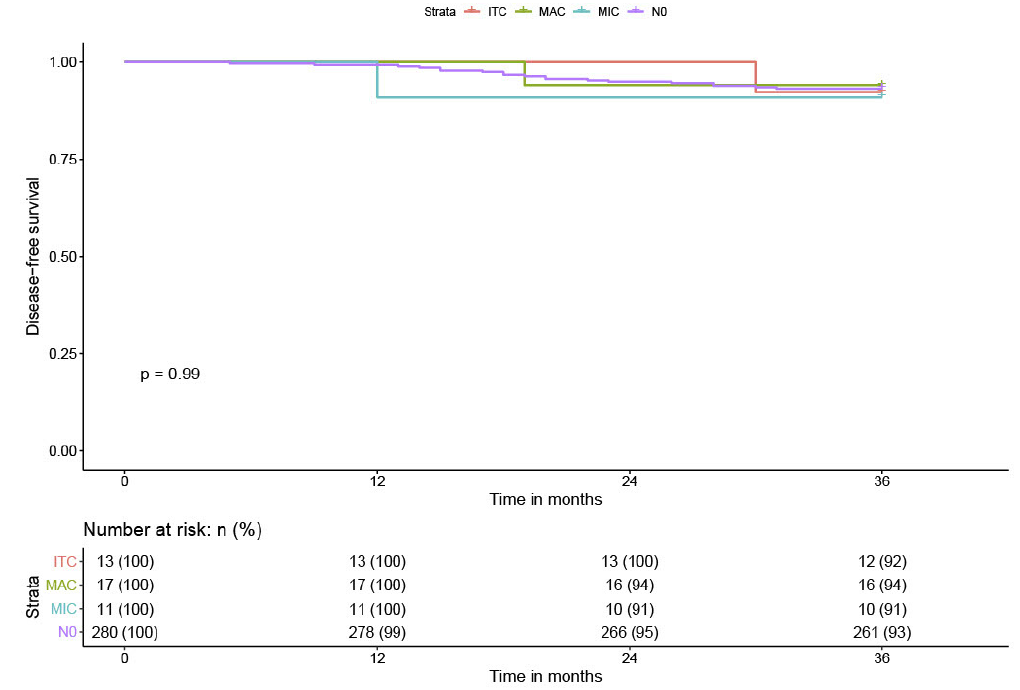
Figure 5. Three-year disease-free survival (DFS) and lymph node status.